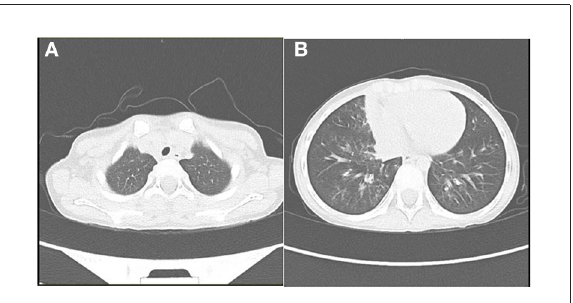
FIGURE1 Patient’s chest CT showed a few inflammatory lesions in the right upper lobe (A) , the middle lobe, and the lower lobe of both lungs and the lower lobe of both lungs (B) on the first day of admission.